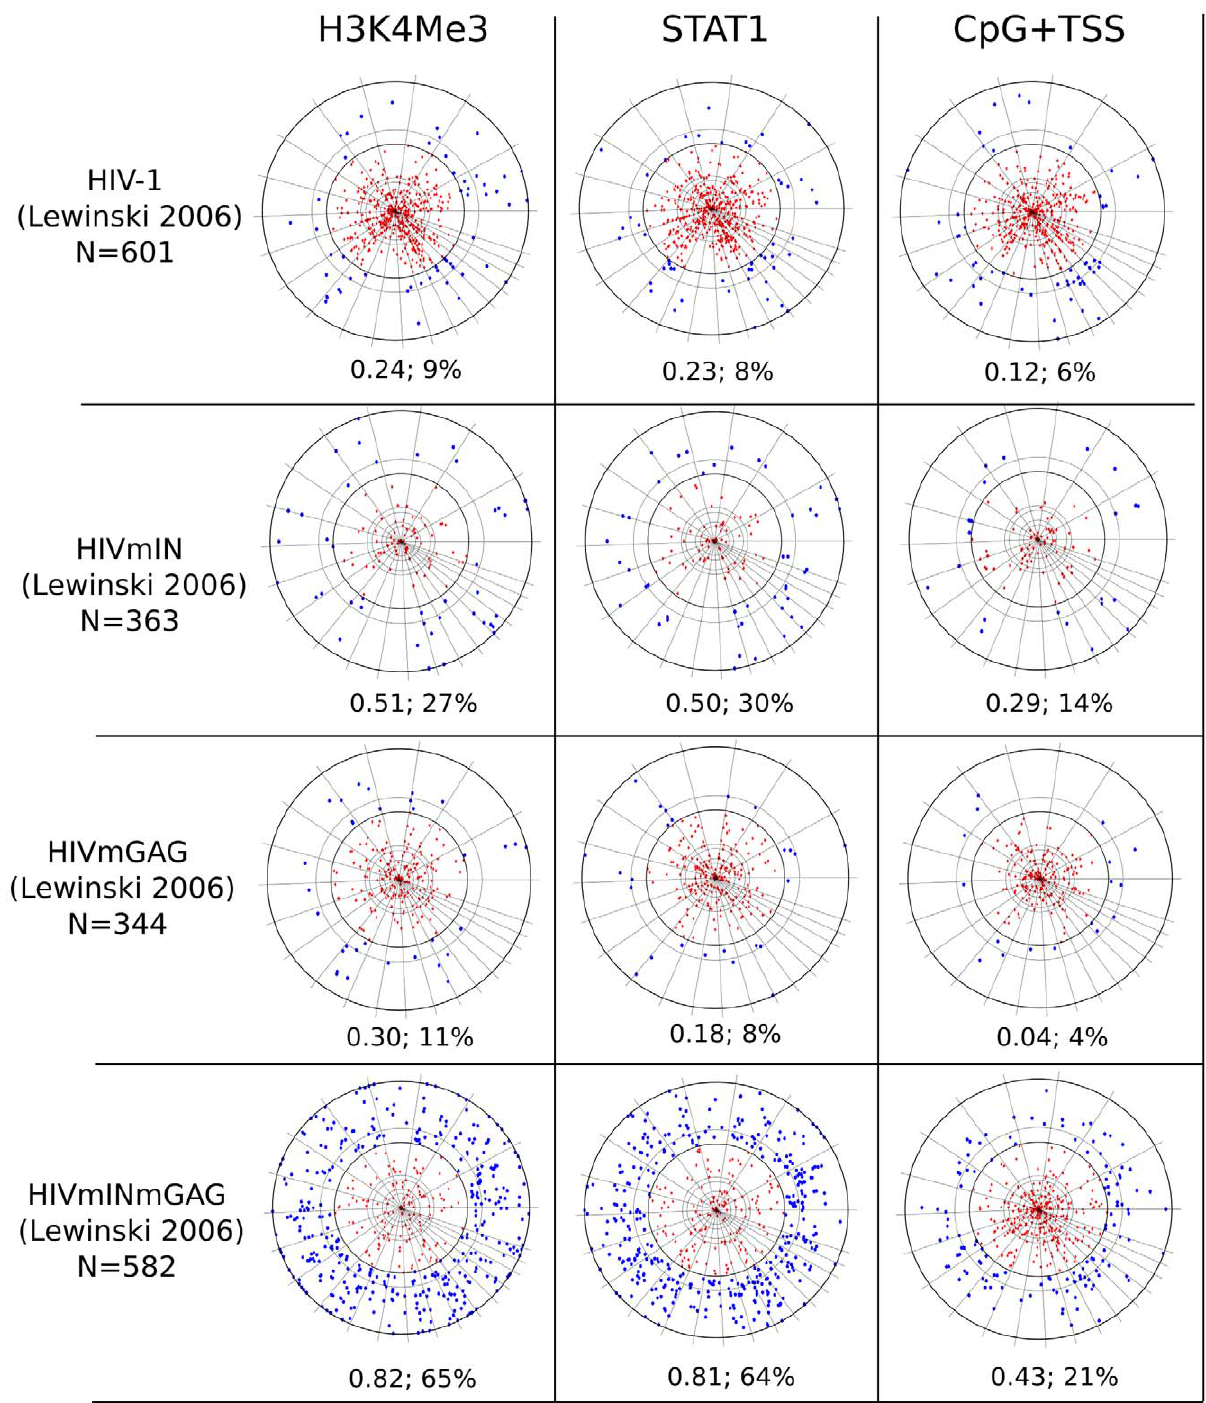
Figure 3. Chromosome projection mandala and F score calculated within 2 kB for the indicated markers (columns) versus the indicated proviruses (rows). All proviruses were cloned from HeLa cells (Table 2 and text). H3K4me3 and STAT1 ChIPSeq datasets were from HeLa cells (Table 1). N indicates the number of specific proviral integrations considered for each analysis. The F score and the percentage of proviruses within 2 kB are presented under each mandala. by the specified metric differs from the rank obtained by significance. similar to that obtained by significance, AUC, AUPR, OR, or All results indicate that, for the datasets evaluated here, the F 0.5 score is DOP (Table 4). SMI scored less well for these markers. a superior measure at discriminating among factors for differences in Figure 8 visualizes the deviation of AUC, AUPR or F 0.5 from magnitude of association with genomic sites of integration. significance. Red squares indicate cases in which the ranking calculated